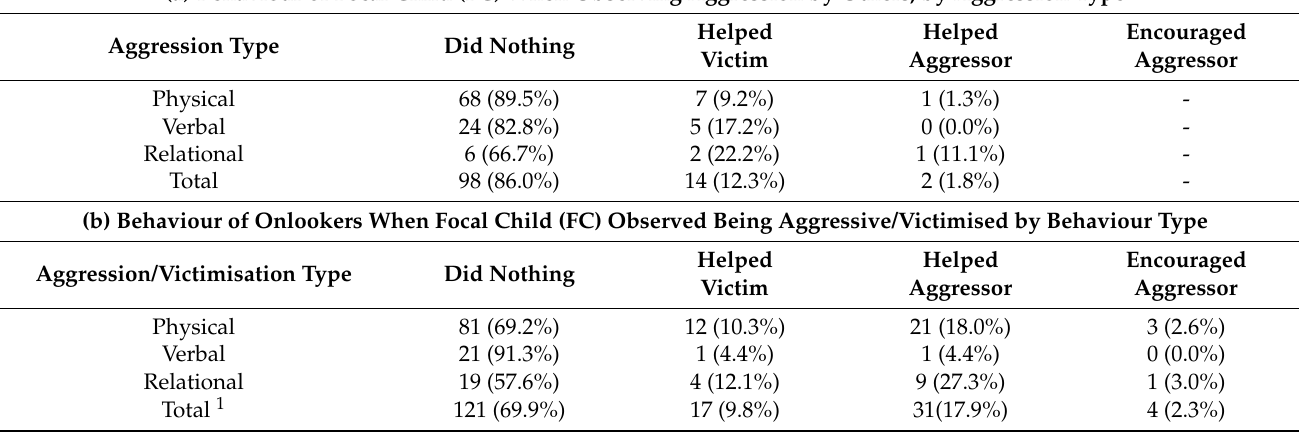
Table 2. Behaviour of onlookers during episodes of aggression/victimisation (number of incidents and percentage of total). (a) Behaviour of Focal Child (FC) When Observing Aggression by Others, by Aggression Type Aggression Type